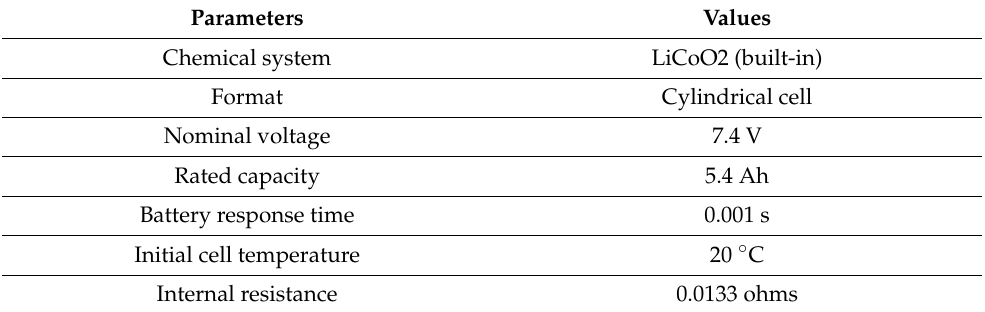
Table 2. Specification of